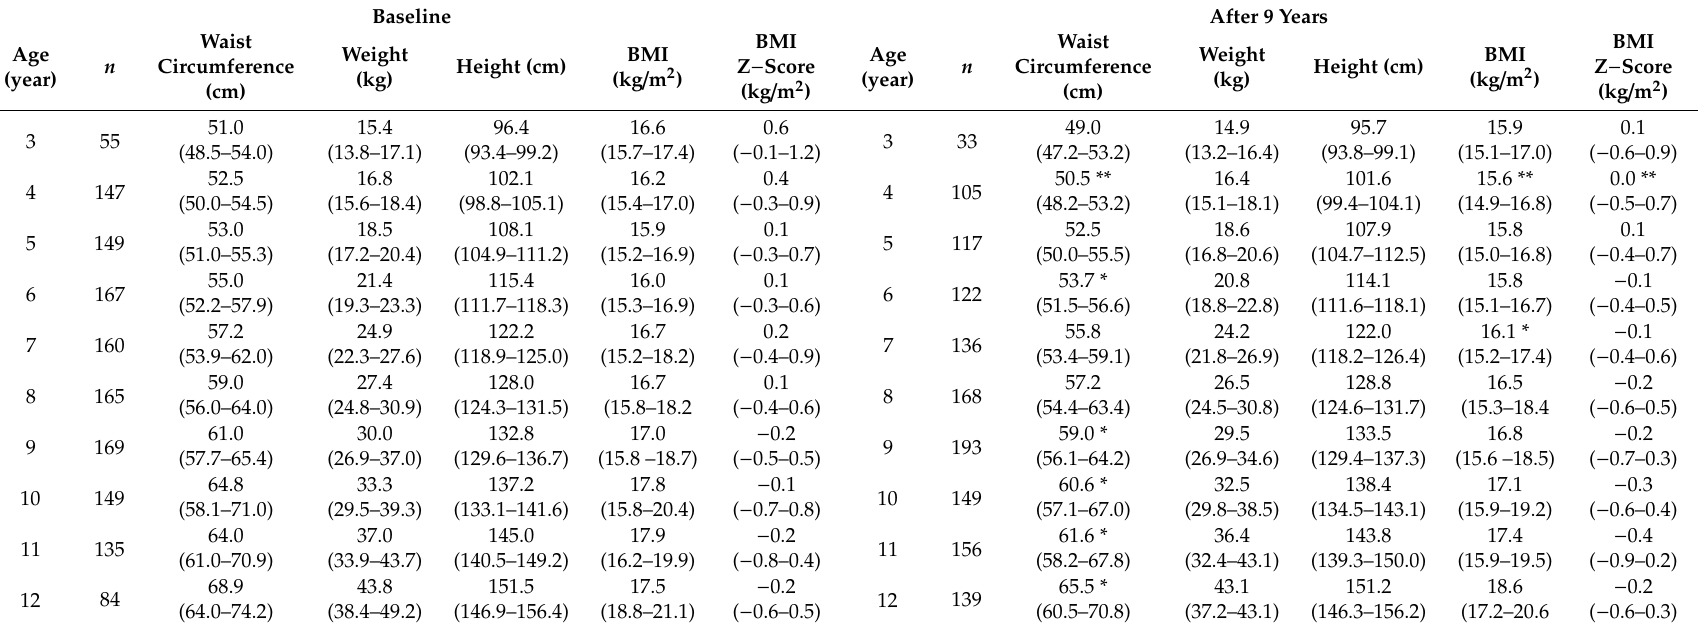
Table 3. Anthropometric variables in girls at baseline and after 9